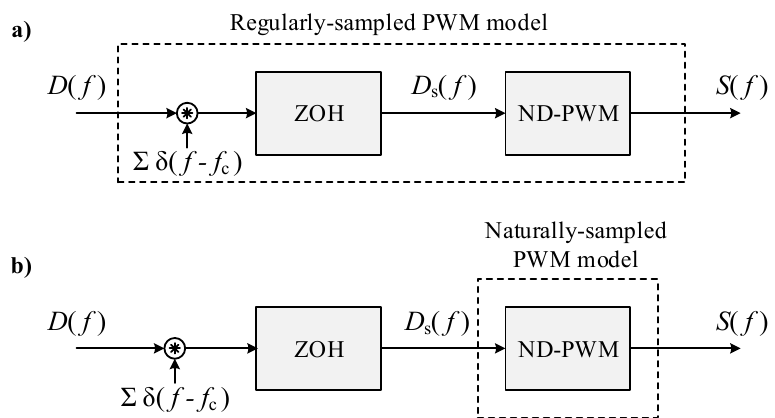
Figure 5. Equivalent methods representing regularly-sampled PWM when the input is the CTFT of the duty cycle D ( f ) : ( a ) The series connection of sampler, ZOH, and naturally-sampled PWM is combined in one mathematical expression. ( b ) The CTFT of the duty cycle D ( f ) is first transferred into the DTFT of the duty cycle D s ( f ) using a model of the sampler and the ZOH. The resulting spectrum is used as the input for the naturally-sampled PWM model [27].